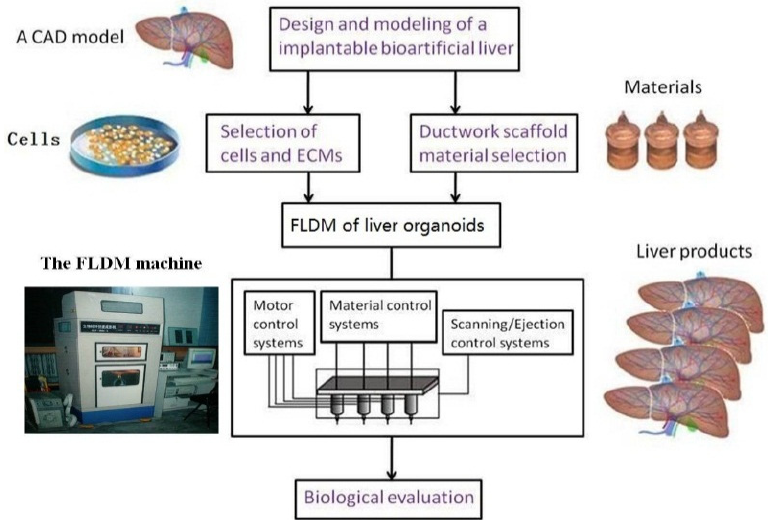
Figure 3. Schematic description of the modeling and manufacturing processes of liver lobes with a four-nozzle low-temperature deposition manufacturing (FLDM) system developed in Tsinghua University, Prof. Wang’s group [10,11].